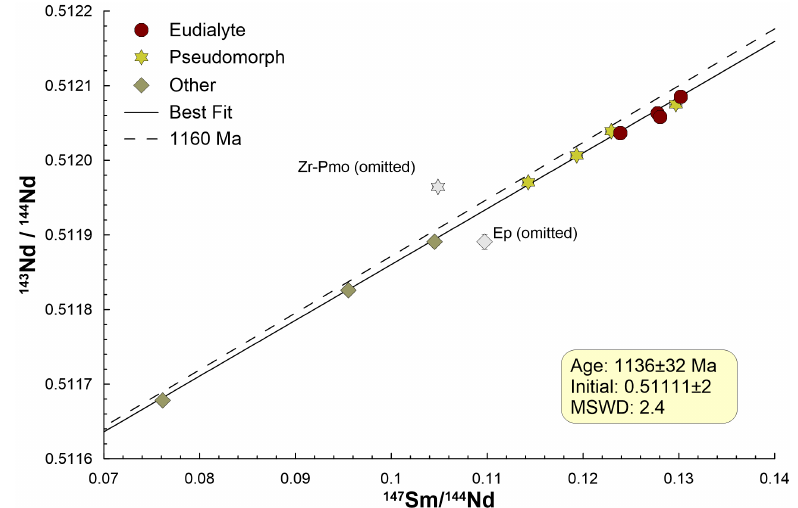
Figure 8. Sm/Nd isochron calculated with omission of the zircon-bearing pseudomorph (Zr-pmo) and the epidote sample (Ep). Double standard error bars are displayed for both ratios but are smaller than the data markers. The isochron for an intrusion age of 1160 Ma ( 143 Nd/ 144 Nd i = 0.51111, [33]) is shown for